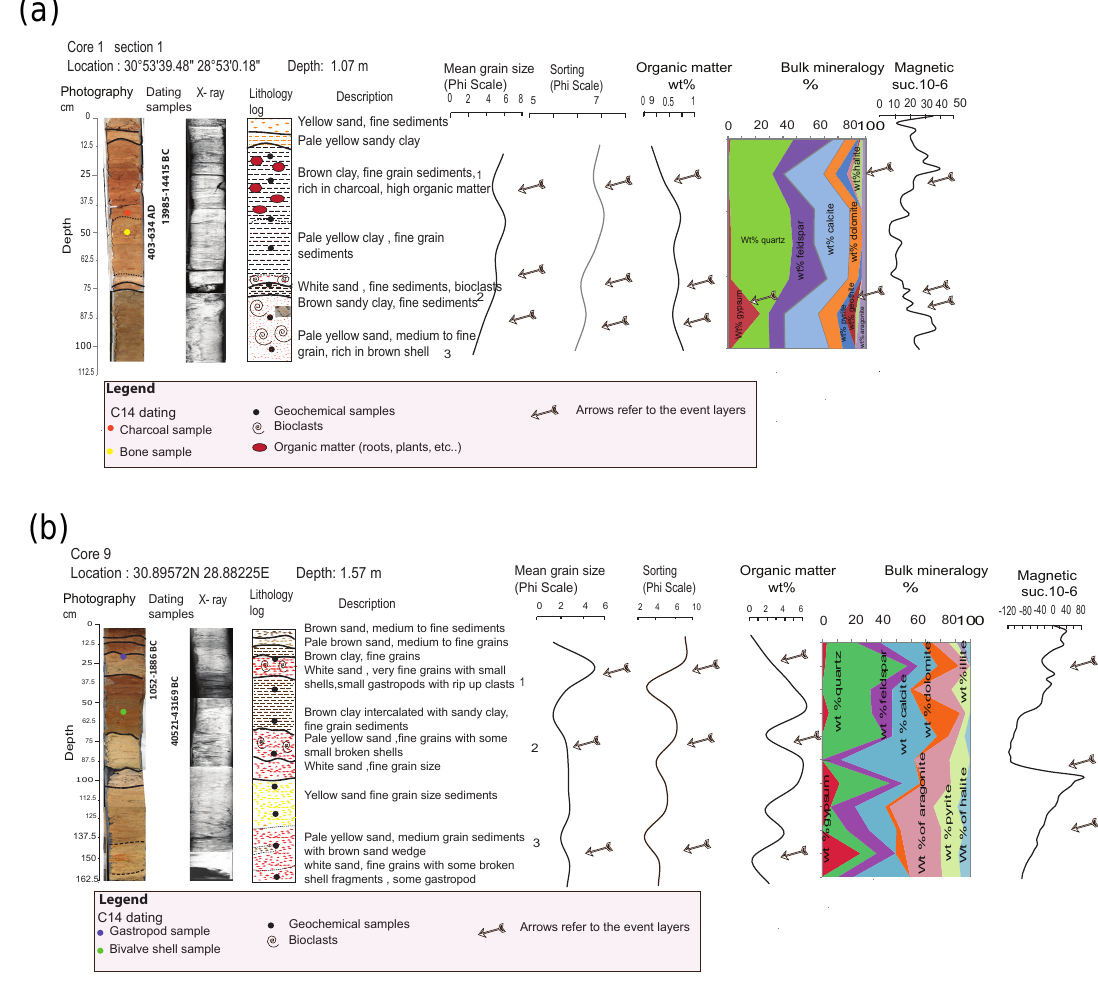
Figure 5. (a) Core 1 log description with X-ray scanning, lithology log, magnetic susceptibility, mean grain size, sediment sorting, total organic and inorganic matter, and bulk mineralogy. The arrows show the high values of each measurement that may correlate with tsunami deposits. (b) Core 9 log description with X-ray scanning, lithology log, magnetic susceptibility, mean grain size, sediment sorting, total organic and inorganic matter, and bulk mineralogy. The arrows show the high values of each measurement that may correlate with tsunami deposits. Illustrations of cores 2–12 are in the